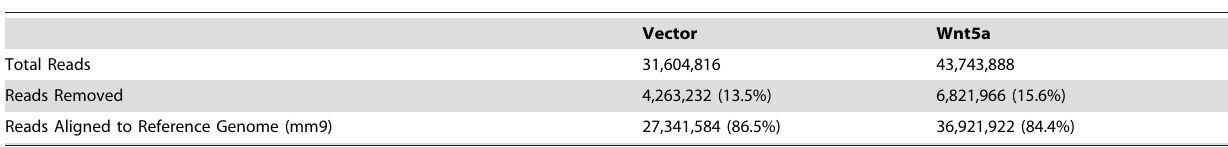
Table 1. Sequence Alignment from CuffLinks.